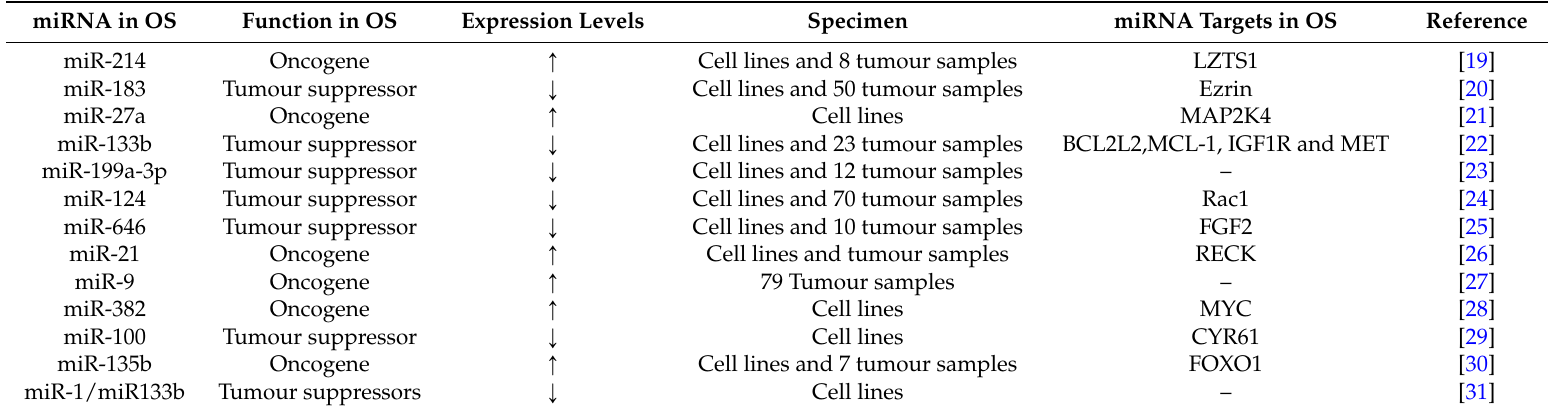
Table 1. List of miRNAs and their target genes involved in regulation of OS. Arrows indicate up-regulation ( Ò ) or down-regulation of ( Ó ) of expression of miRNAs in osteosarcoma.